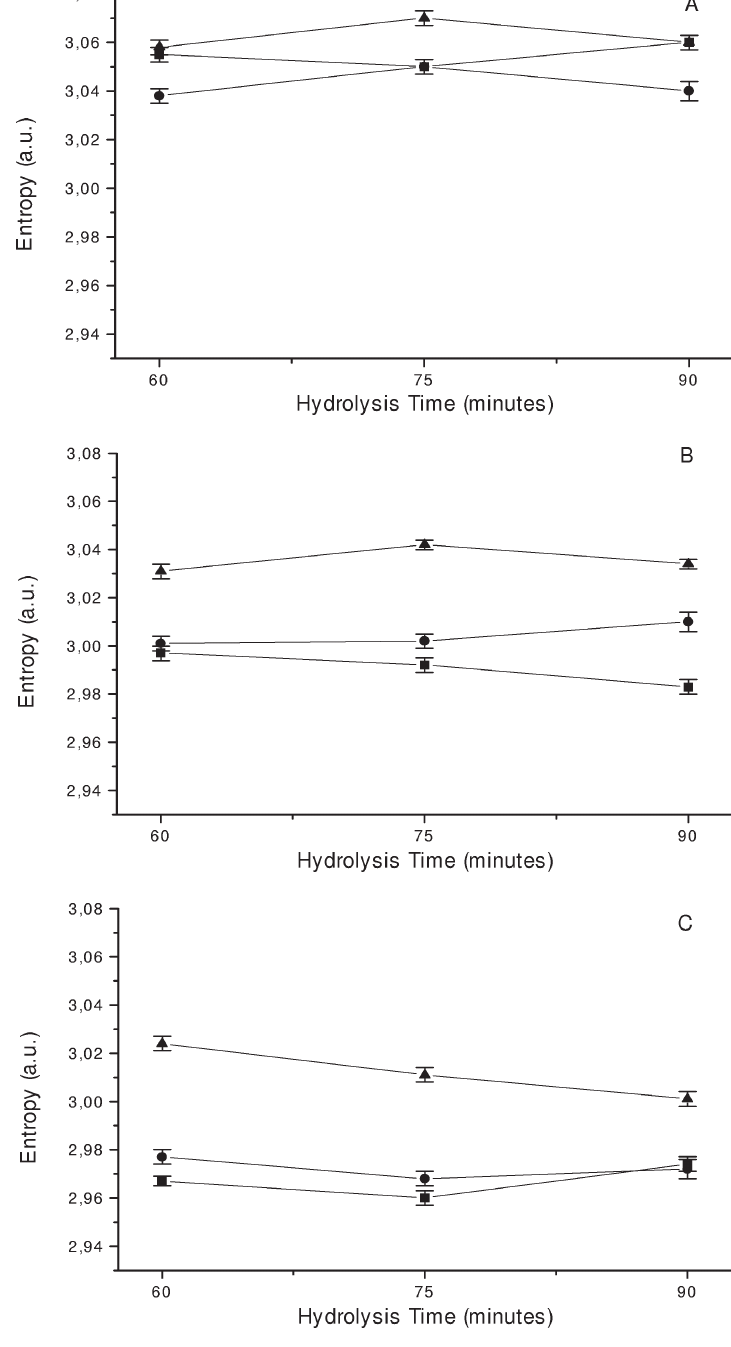
Fig. 4. Mean values ( (cid:6) SEM) of entropy in the plateau range of hydrolysis curve for lymphatic cells (A), epithelial cells from buccal mucosa (B) and uterine myometrial cells (C) fixed by different types of fixatives: (cid:4) – Delaunay, (cid:15) – Saccomanno, N – air-drying with postfixation in modified Böhm–Sprenger